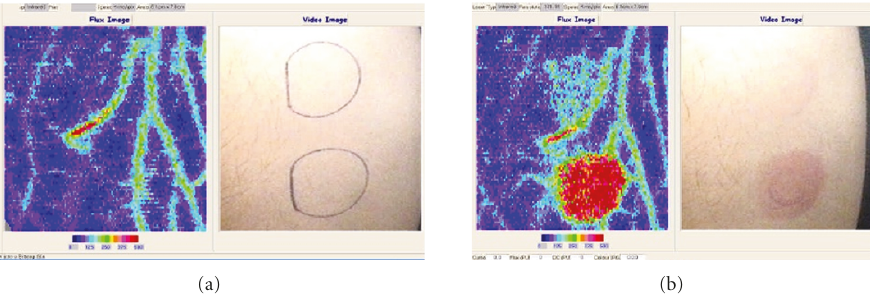
Figure 2: The LDI range features a CCD camera which produces a color image of the scanned area, making the positioning and comparison of images easier. (a) Before UVB irradiation. (b) After 100 and 200 mj/cm 2